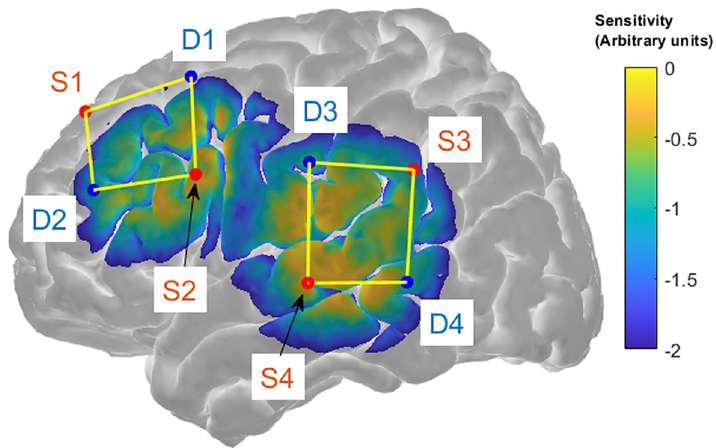
Figure 2. Sensitivity profile and sensor channel locations for the left temporal and prefrontal regions. The sensitivity of each probe to detecting brain hemodynamics is represented on a logarithmic color scale ranging from − 2 to 0 (arbitrary units; higher number indicates higher sensitivity). Source and detector positions are indicated by the red and blue circles and corresponding labels respectively, and yellow lines show channels. This figure was generated with AtlasViewer 29